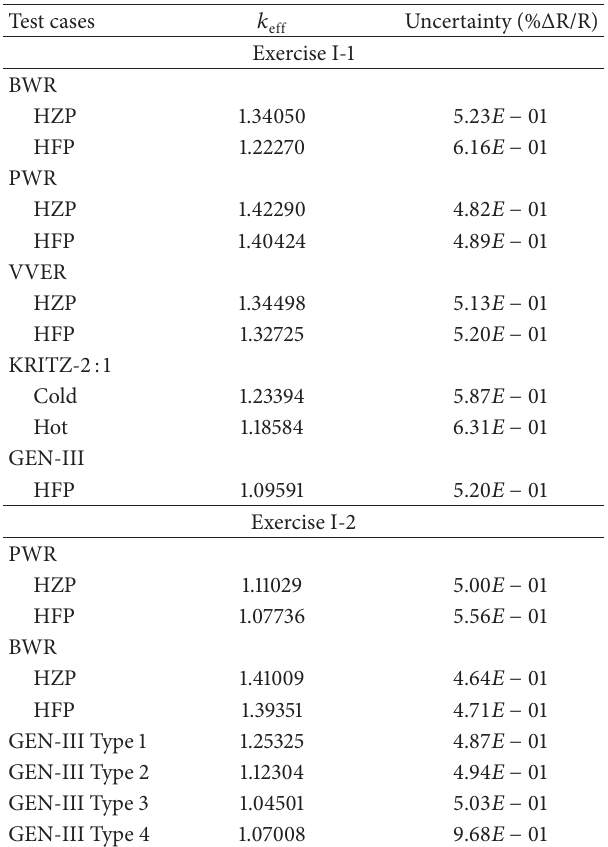
Table 2: Exercises I-1 and I-2